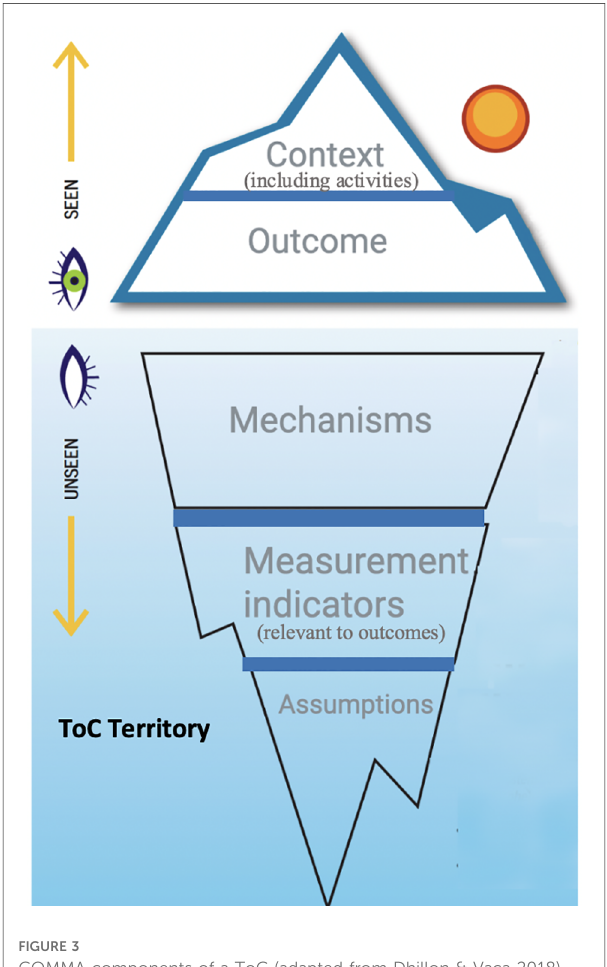
FIGURE 3 COMMA components of a ToC (adapted from Dhillon & Vaca